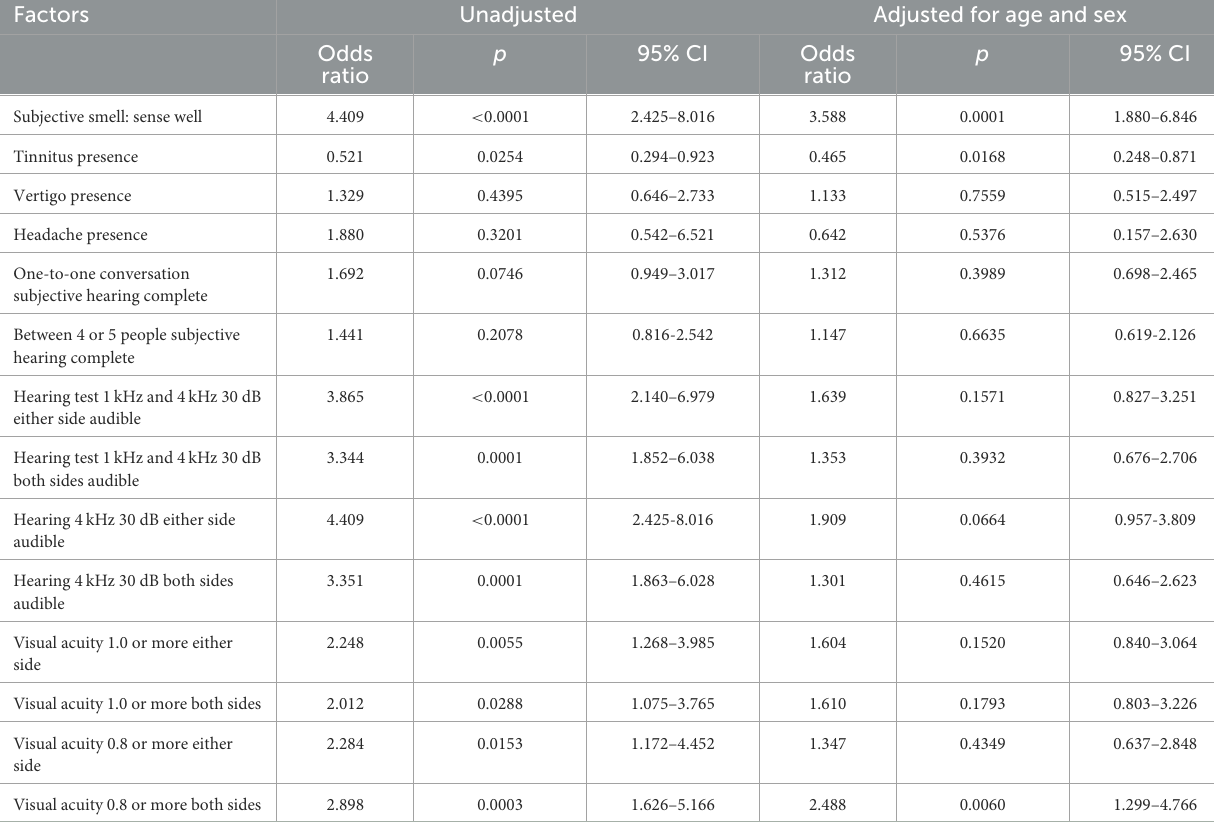
TABLE 3 Influence of various factors on smell test